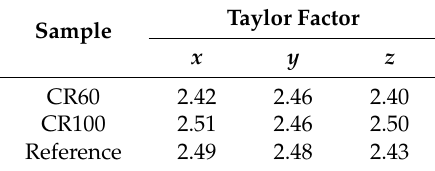
Table 4. The calculated mean values of the Taylor factor are listed for each sample.